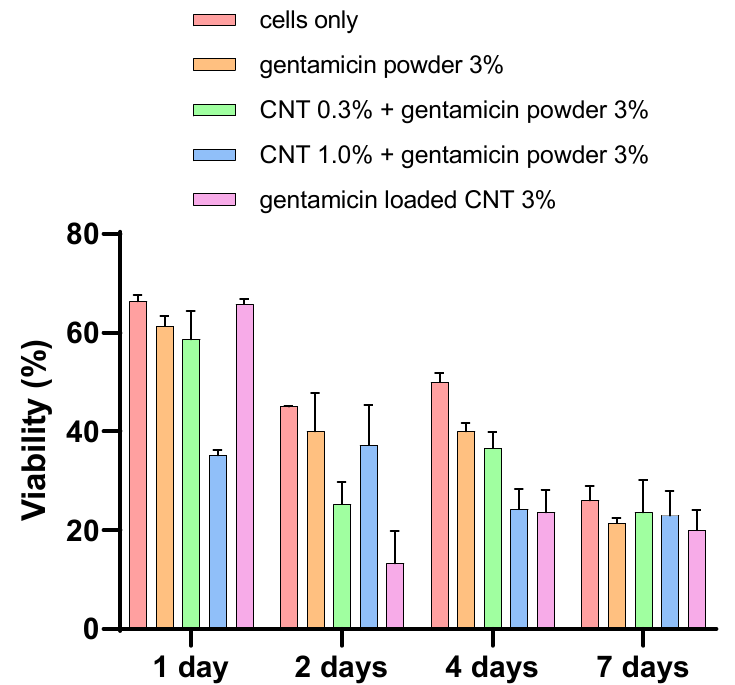
Figure 10. Cytocompatibility test (LDH assay) for osteoblasts with different cements types ( n = 6 ± SD).